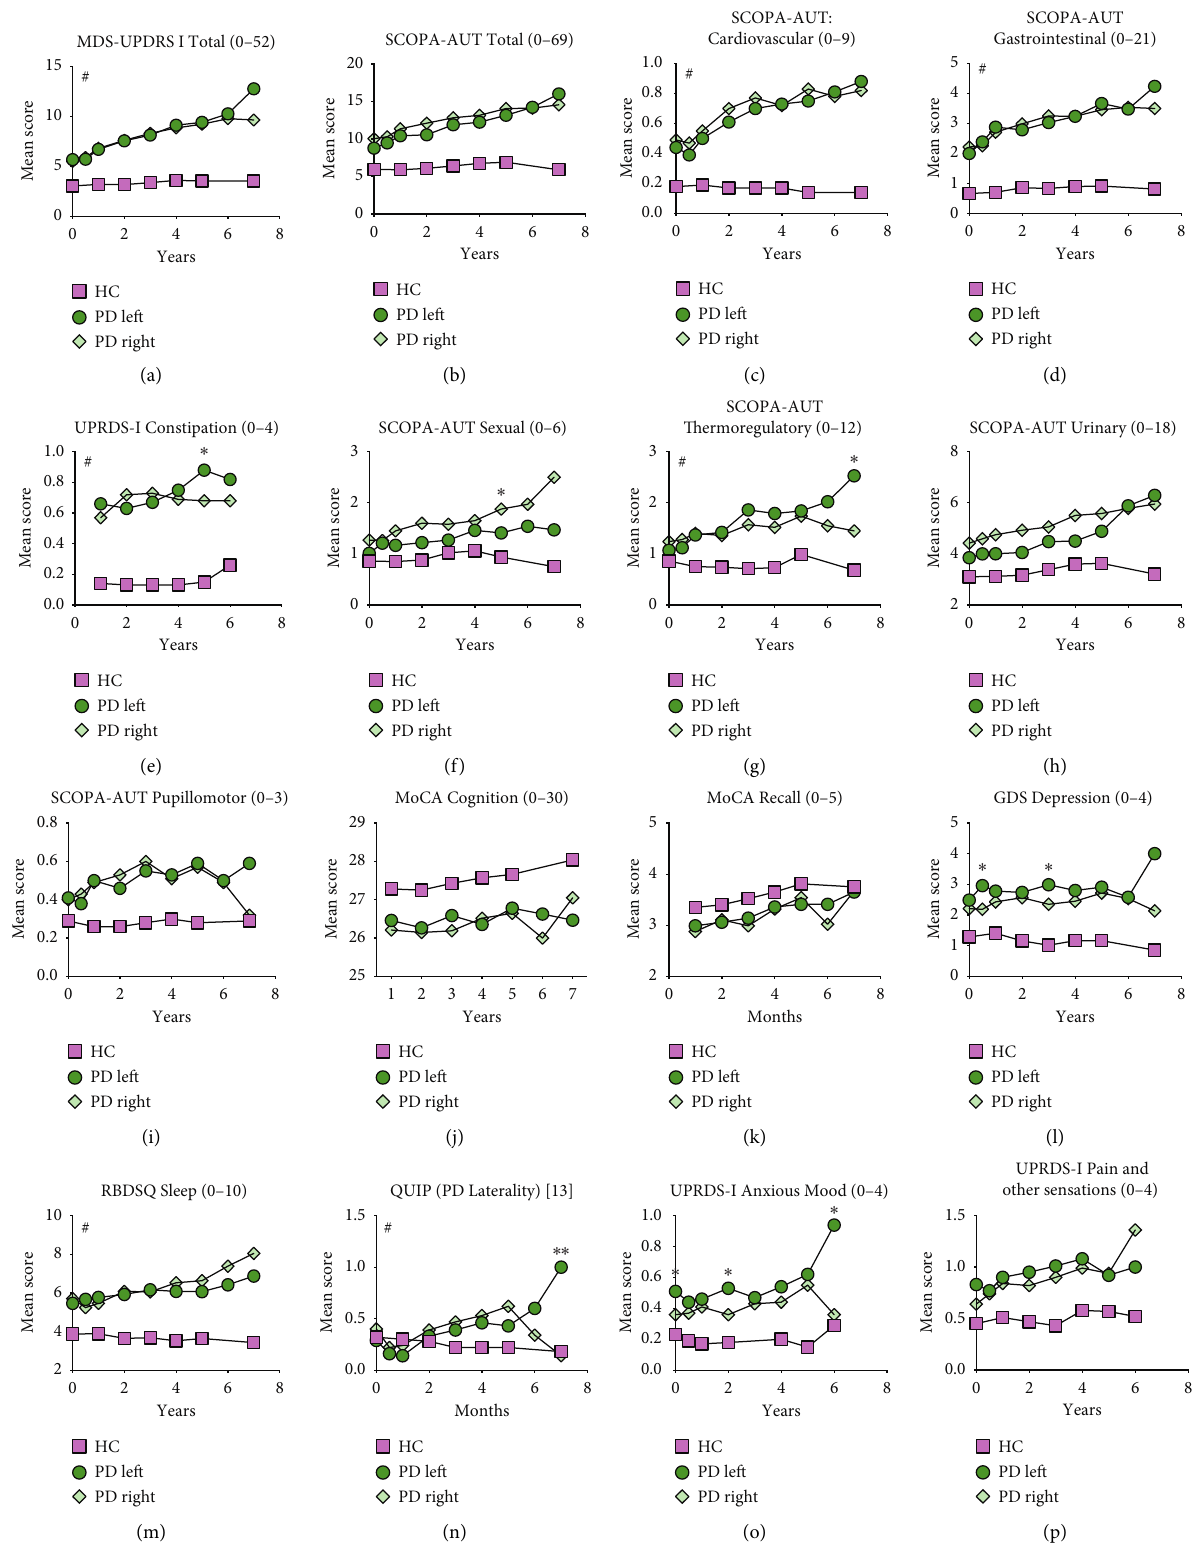
Figure 4: Progression of NMS in PD cohort categorized by laterality of motor symptoms at onset. NMS mean scores were categorized by laterality of motor symptom onset (left or right) for Parkinson’s disease (PD) and healthy controls (HC) and mean scores for each scale were graphed for follow-up visits up to 7 years. NMS scales analyzed are displayed A through P indicating the score range in the title of individual graphs. Higher number indicates more dysfunction except for MoCA Cognition (J). Differences in mean scores within PD cohort (left vs. right) were evaluated using two-way ANOVA with multiple comparisons for each time point. Statistically significant differences between PD Left and PD Right are indicated by an asterisk ∗ . Statistically significant ANOVA interaction of time and cohort on NMS scale are indicated by #. p < 0 .